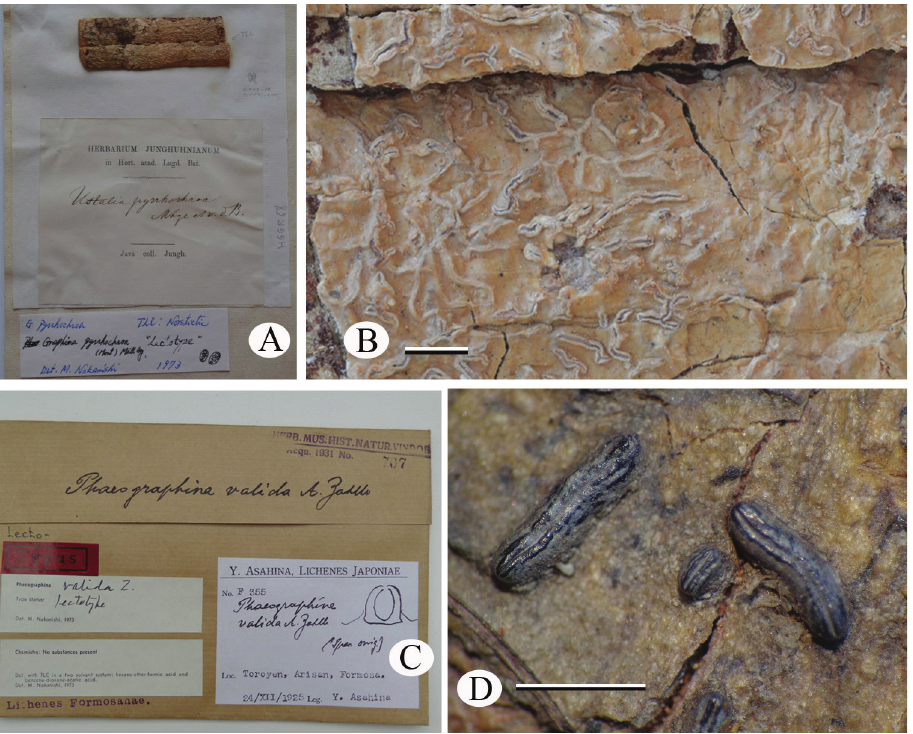
Figure 6. A–B Ustalia pyrrhochroa Mont. et Bosch ( Junghuhn s.n. ) C–D Phaeographina valida Zahlbr. ( Asahina 355 ). Scale bars =